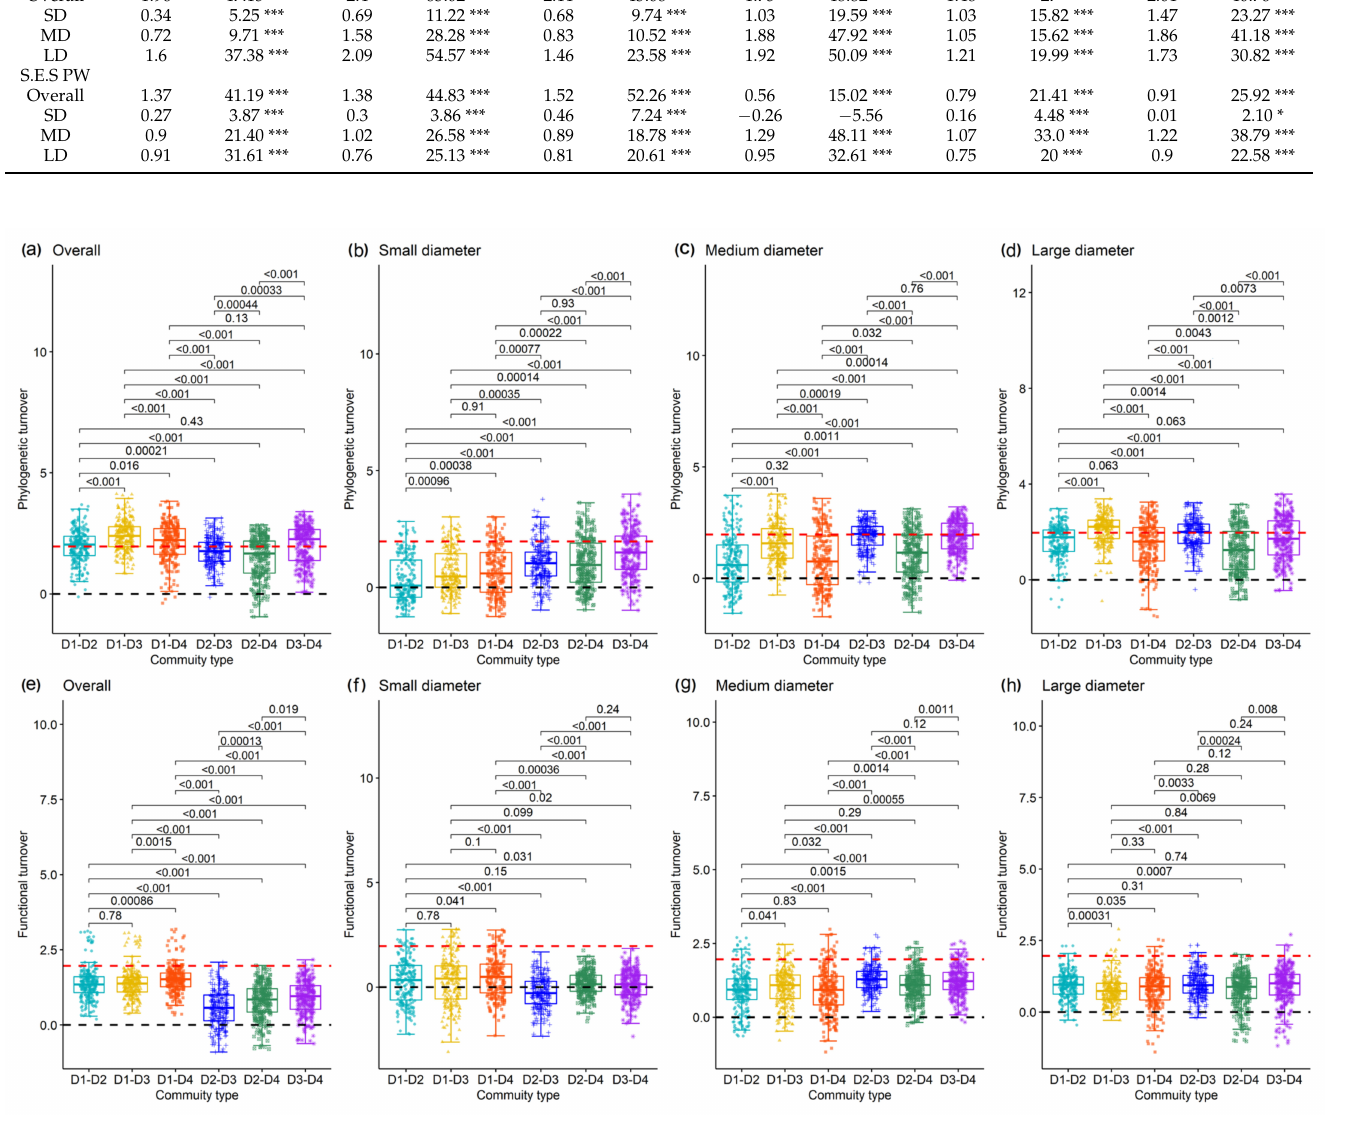
Figure 5. Phylogenetic ( a – d ) and functional ( e – h ) turnover between the four disturbance regimes; ( a , e ) are the overall diameter species, ( b , f ) are the small diameter species, ( c , g ) are the medium diameter species, ( d , h ) are the large diameter species. Black dashed lines indicate turnover = 0. Red dashed lines indicate turnover = 1.96. D1, D2, D3, and D4 represent the plantation, twice-cut, once-cut, and old-growth forests, respectively. Lines joining boxes show the results of Wilcoxon tests between disturbance regimes ( p ≤ 0.05 level of